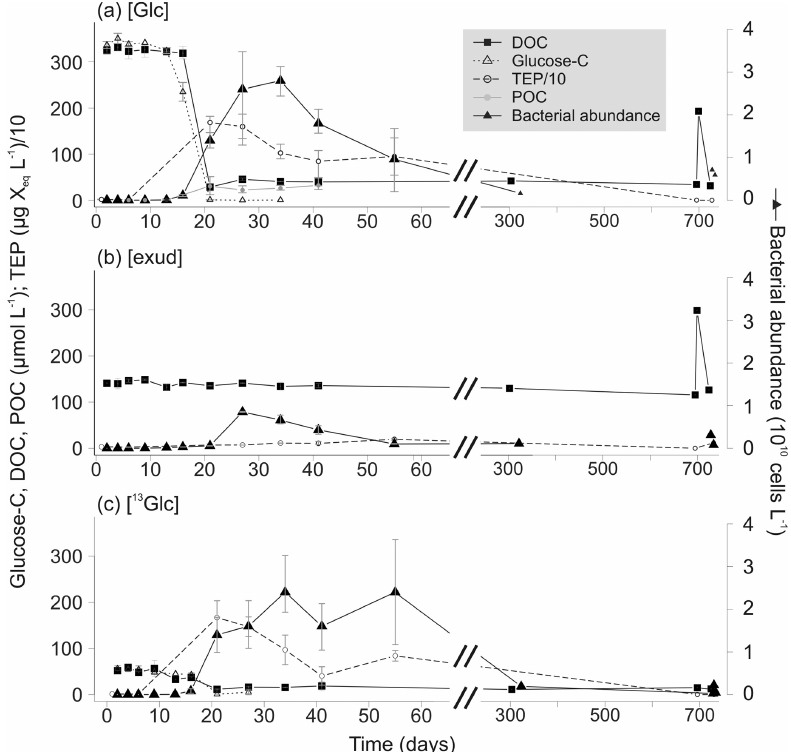
Figure 3. Concentration changes with time for the microbial degradation of (a) glucose [Glc], (b) algal-derived exudates [exud] and (c) 13 C- labeled glucose [ 13 Glc] treatments: dissolved organic carbon (DOC), particulate organic carbon (POC, only available for [Glc] treatments), glucose, transparent exopolymer particles (TEP) and bacterial abundance (bac, right y axis). Error bars represent the range of values based on triplicates for [Glc] and duplicates for [exud] and [ 13 Glc]. On day 699, ∼ 170µM glucose-C was added to one [Glc] and one [exud] bottle (singular